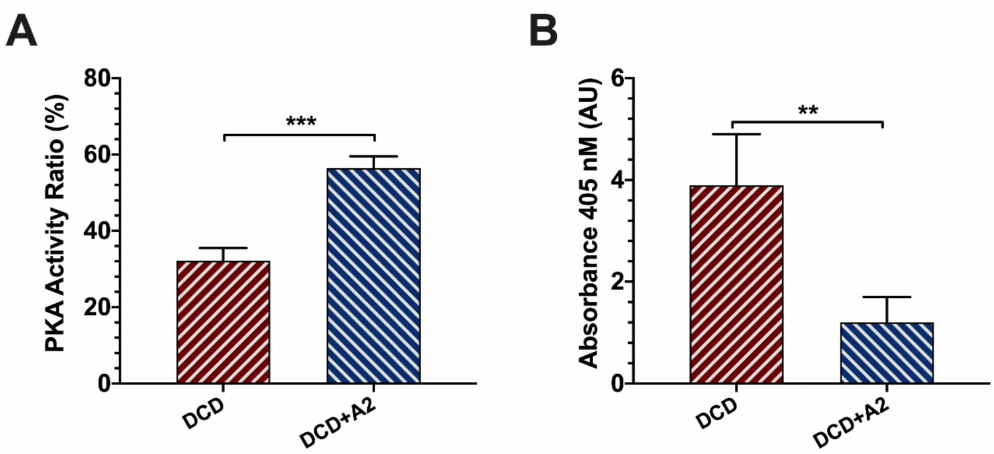
Figure 4. PKA activation and corresponding DNA fragmentation and apoptosis. ( A ) Serum activity of protein kinase A (PKA) after 1 hour of reperfusion shown in activity ratio in the DCD and DCD + A2 groups. (mean ± s.e.m., *** p < 0.001 DCD + A2 vs. DCD, Student’s t-test, n = 5 / group). ( B ) Serum levels of histone-associated DNA fragments after 1 hour of reperfusion are shown in arbitrary units (AU) of absorption in the DCD and DCD + A2 groups. (mean ± s.e.m., ** p < 0.01 DCD + A2 vs. DCD, Student’s t-test, n = 5 /